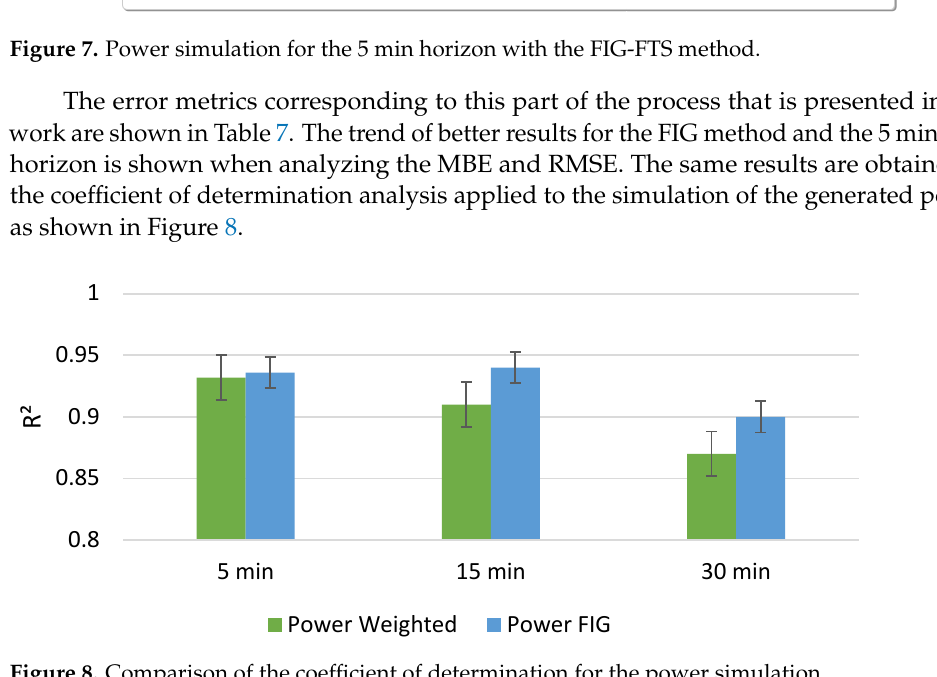
Figure 8. Comparison of the coefficient of determination for the power simulation.